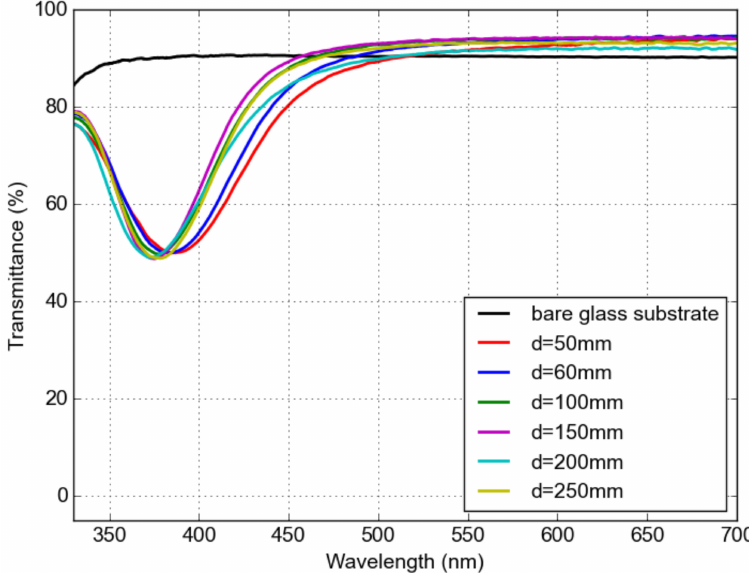
Figure 8. Optical transmission measurement of a LiF and Ag NP nanocomposite on a glass substrate for various target–orifice